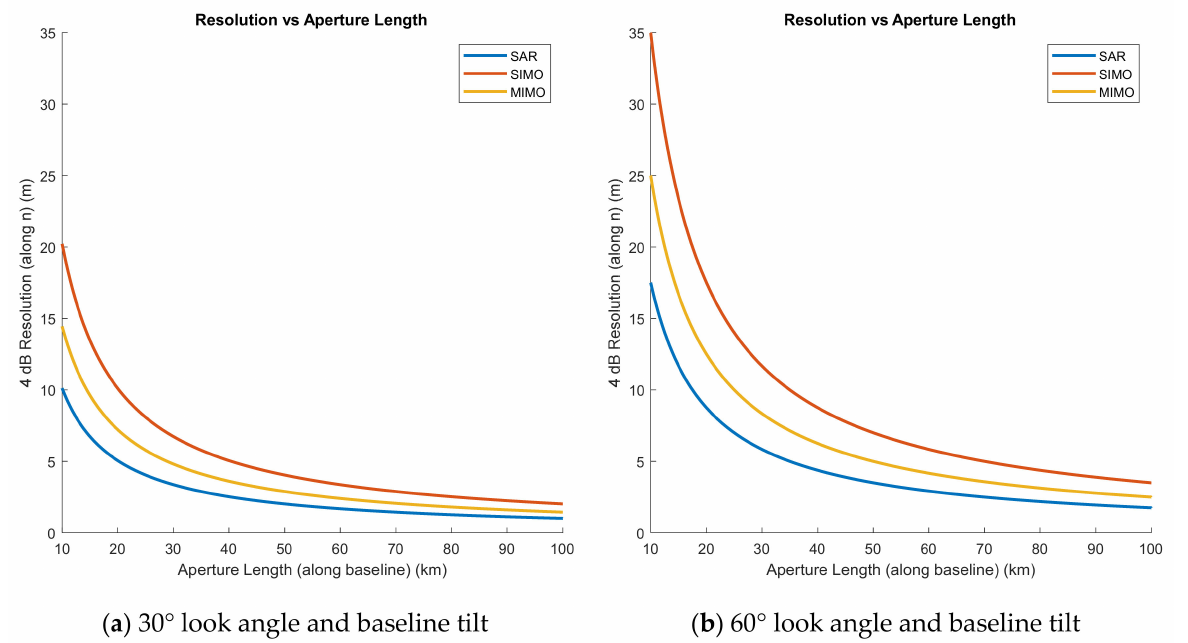
Figure 12. Tomographic resolution (along n ) vs. aperture length (along n ) for two different look angles. Figure 13 shows nearest ambiguity location along n ( A 1 ) vs. platform spacing along n n ( µ n ) for two different look angles. It is assumed that the baseline tilt angle ( α ) is equal to look angle ( θ ). Therefore, the perpendicular platform spacings in the plots can also be considered as the actual platform spacings. The spacing among platforms is assumed to be equal (linear). No windowing is applied.